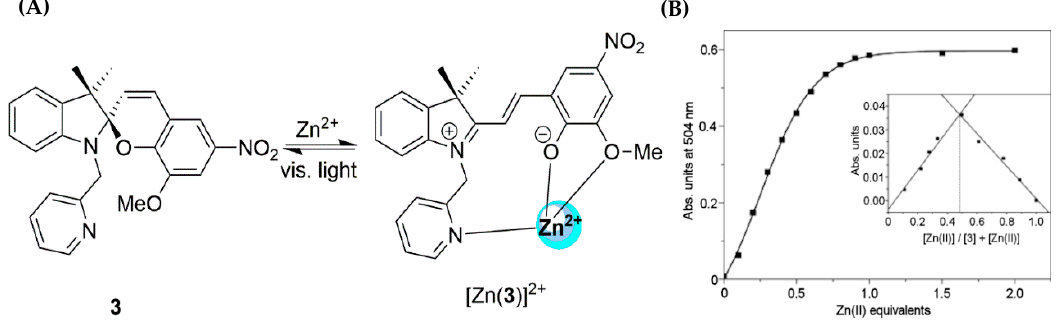
Figure 2. ( A ) The proposed binding of Zn 2+ and molecular probe 3 ( B ) The absorption binding isotherm obtained, upon the addition of Zn(ClO 4 ) 2 to a 1 × 10 − 4 M of 3 in CH 3 CN solution and Job’s plot (insert). Unfortunately, the calculated binding constant was not calculated using the non-linear regression presented. Adapted from [135], with permission from Elsevier.